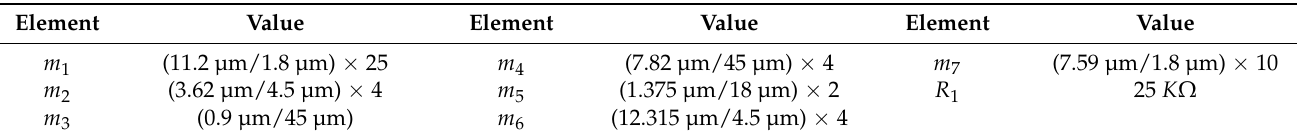
Figure 18. Location of the implemented shunt regulator inside the microphotography of the whole self-powered tag and a zoomed-in view of its layout. Table 6. Elements and transistor sizes of the shunt